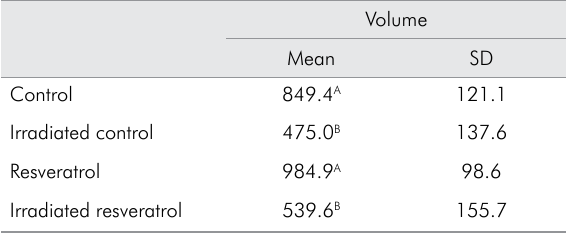
Table 1. Volumetric mean values ( ± SD) of the region of interest according to the evaluated groups (mm 3